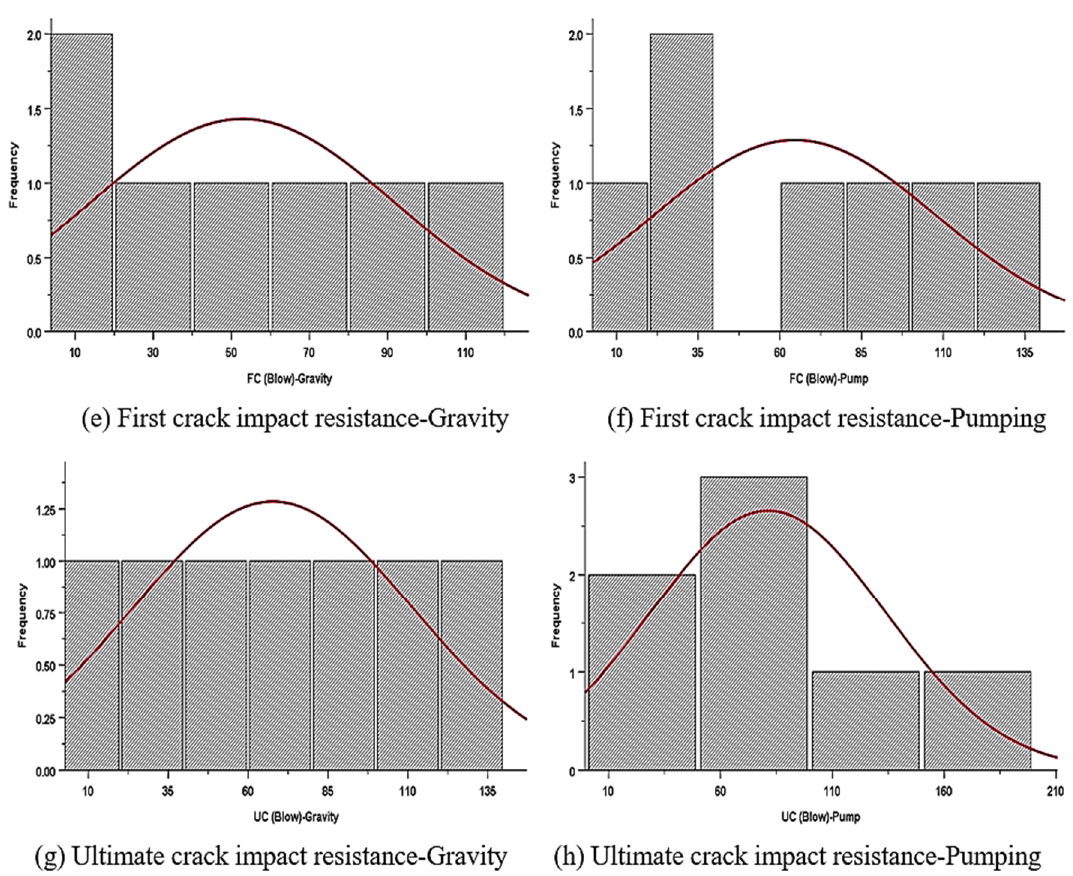
Figure 13. Histograms of strength properties of PAFRC specimens.